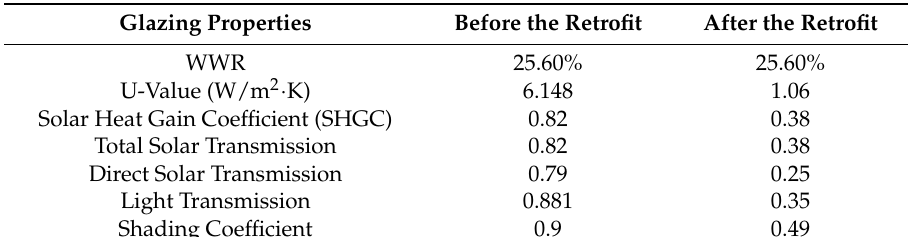
Table 8. Glazing specifications in the base model and retrofit model.